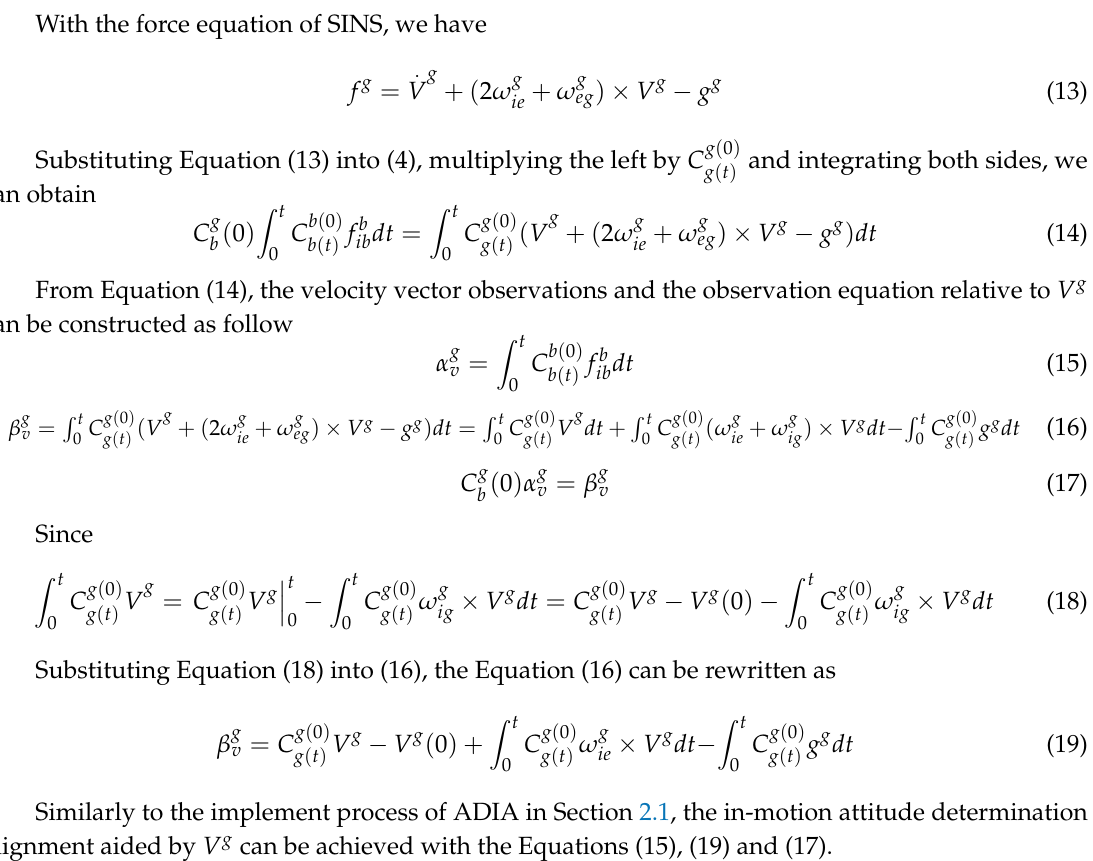
Figure 1. Implement process of the ADIA assisted by the recursive Davenport’s q-method.